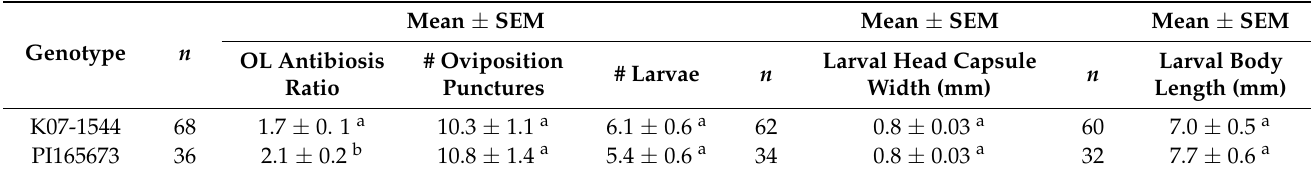
OL antibiosis ratio = (number of oviposition punctures/number of larvae), SEM: Standard Error of Mean; n : number of plants. Means followed by a different lower-case letter within a column are statistically different based on a Fisher’s protected LSD ( p < 0.05) means separation test. Means within a column with same uppercase letter are not significantly different based on an F-test ( p > 0.05). # oviposition punctures (F 1,103 = 0.08, p > 0.05), # larvae: F 1,103 = 1.11, p > 0.05), larval head capsule width (F 1,85.1 = 0.32, p > 0.05), larval body length (F 1,12.4 = 1.34, p >